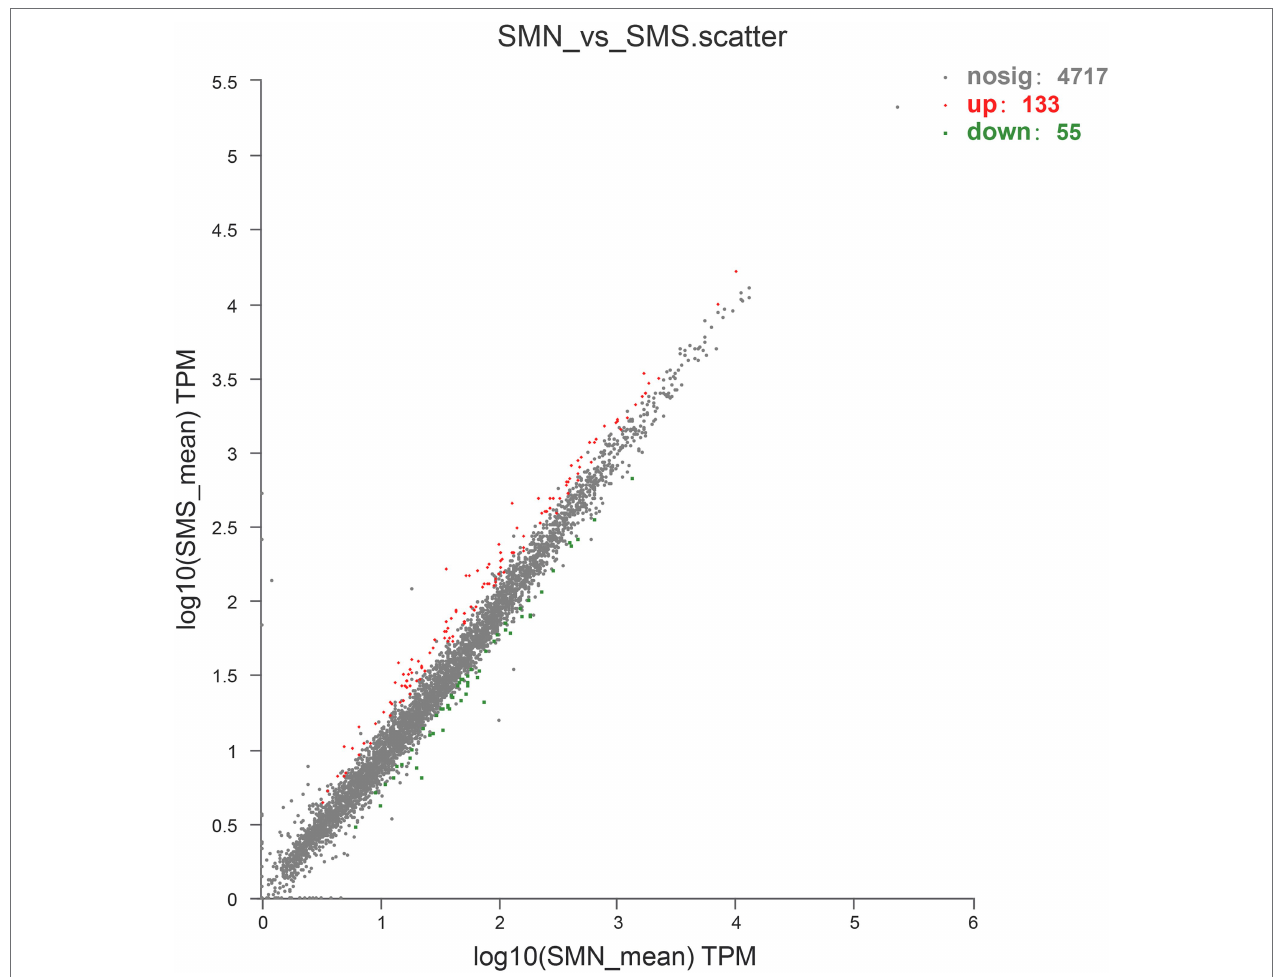
FIGURE 7 | Upregulated and downregulated genes expressed in SMS compared with that in SMN. The values of the abscissa and ordinate have been algorithmized, and each point represents a specific gene. The abscissa corresponding to a specific point is the expression level of the gene in SMN, and the ordinate is the expression level of the gene in